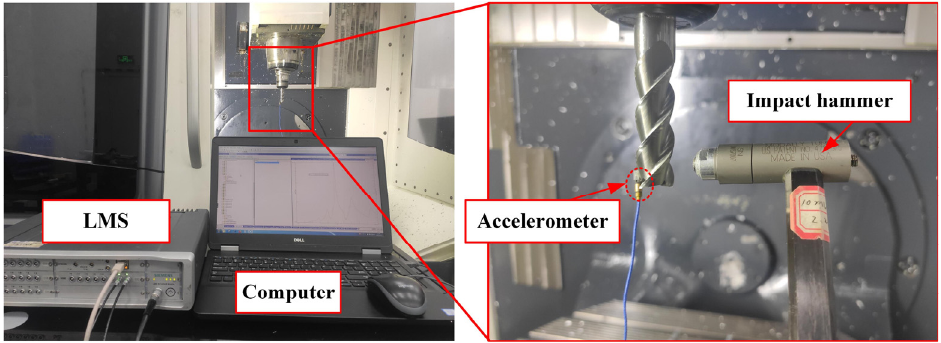
Figure 7. FRFs testing of tool tip.